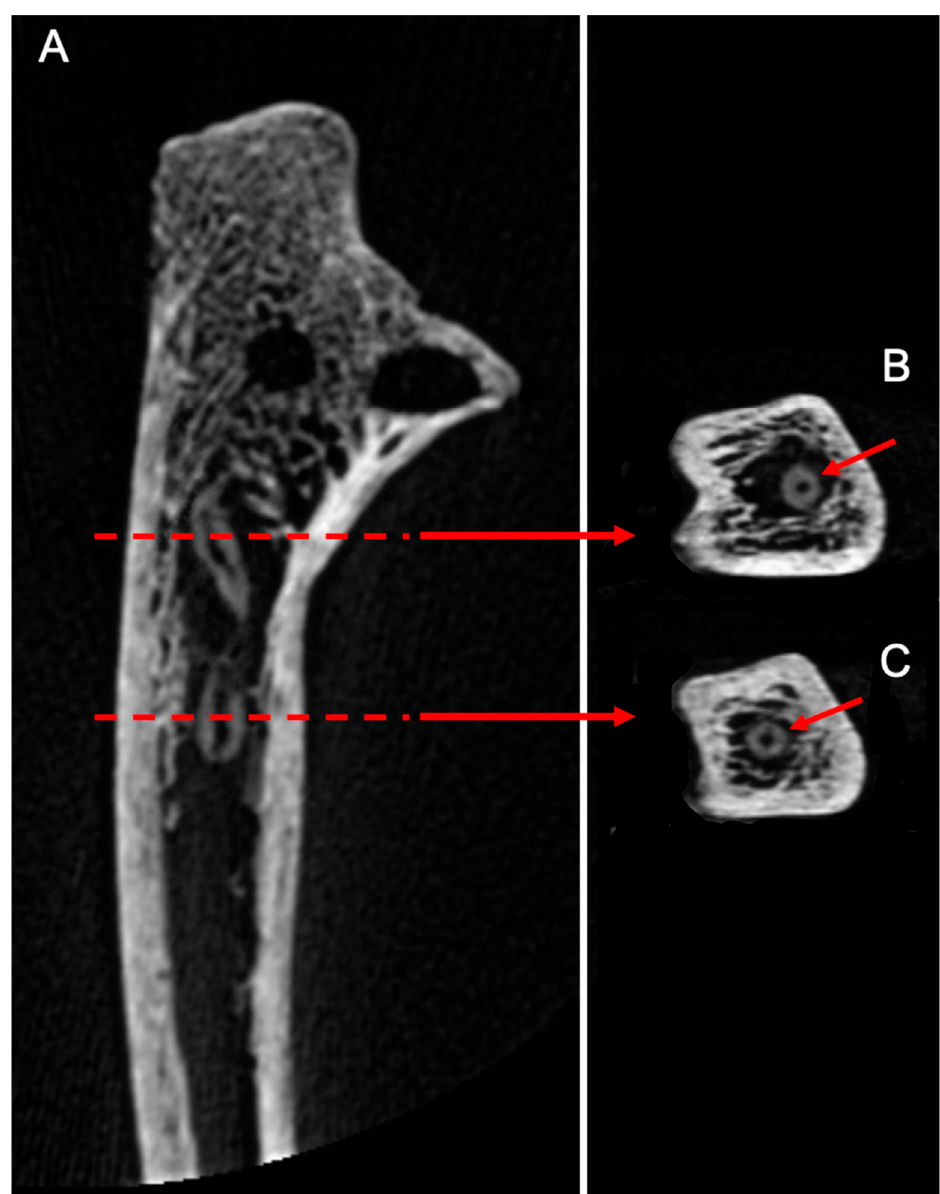
Figure 4. ( A )/CBCT longitudinal section of the human ulna. X-rays allowed us to locate nymphs inside the medullary cavity, associated with trabecular bone destruction, attesting the presence of dermestids inside the bone. ( B , C )/Cross-sections of the molts showing a round cuticular section with a central cavity.